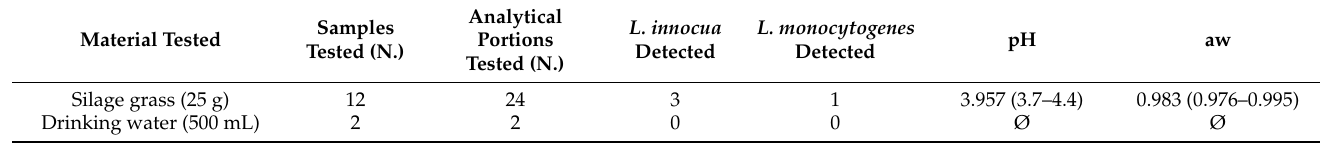
Table 3. Listeria spp. and L. monocytogenes culture-dependent testing on feed and water. Ø = Not tested.